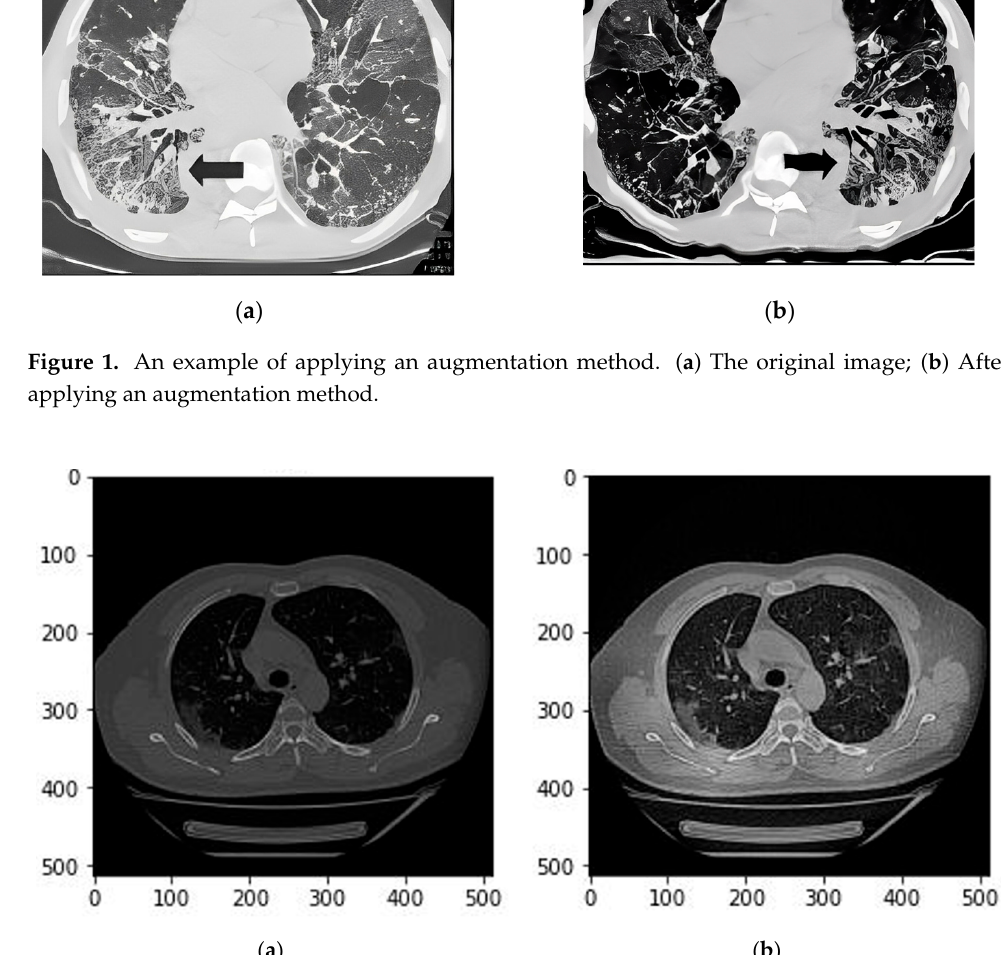
Figure 2. ( a ) Before applying a CLAHE filter; ( b ) After applying a CLAHE filter.